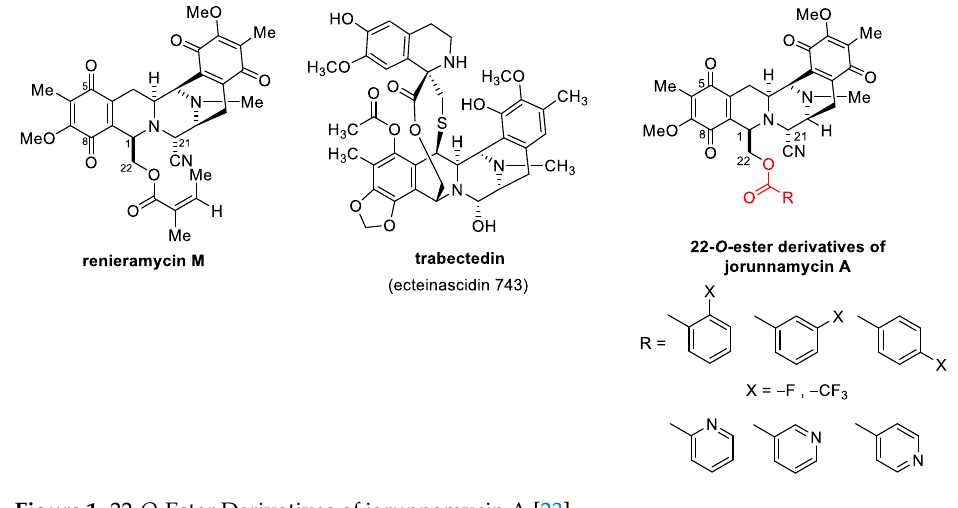
Figure 1. 22- O -Ester Derivatives of jorunnamycin A [23].